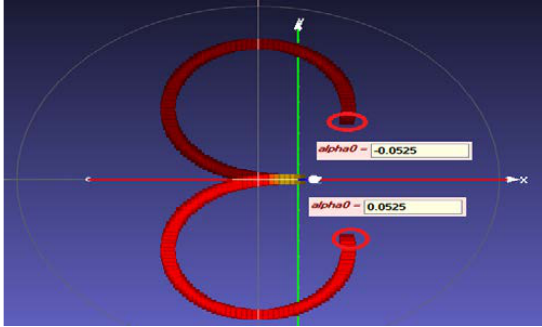
Fig. 5. Iterative algorithm for controller